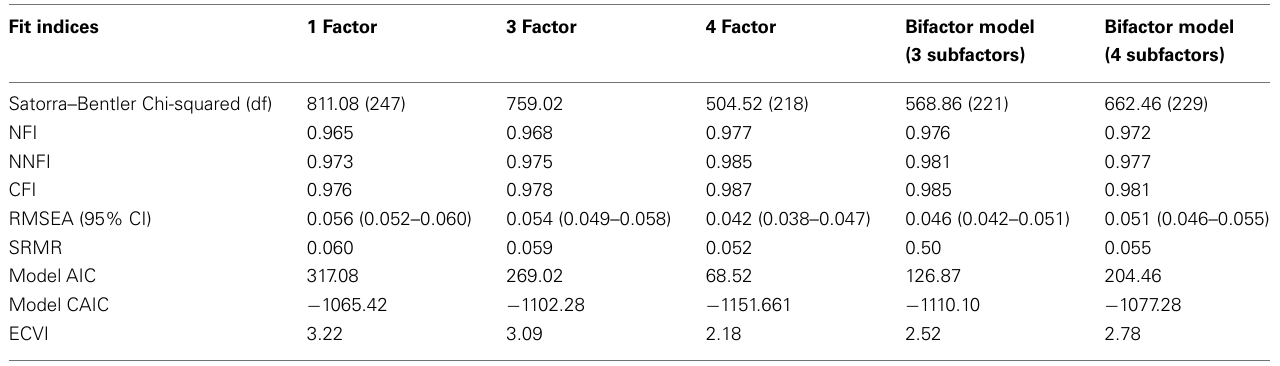
Table 2 | Goodness-of-fit indices for the one-, three-, four-factors, and bifactor models of the CSI-24. Fit